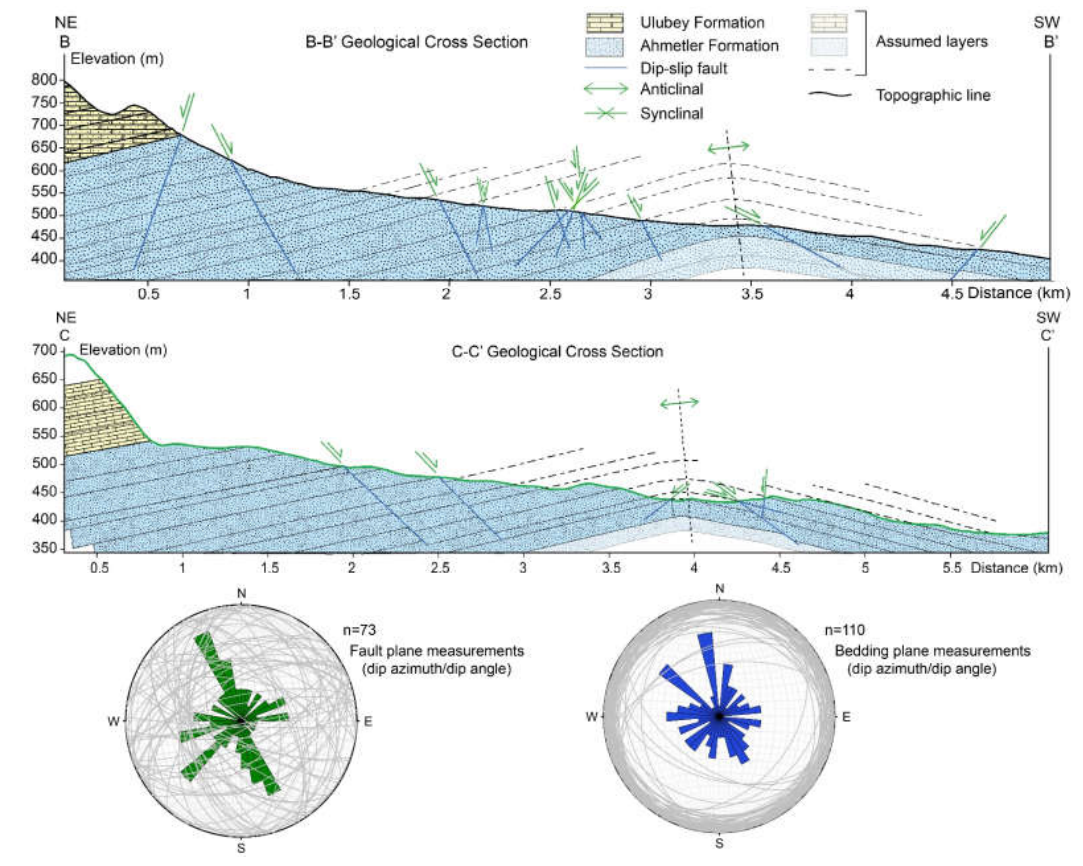
Figure 10. Geological cross sections of bedrock showing the fault geometry and rock structure. There is a vertical exaggeration. Both vertical and horizontal scales are indicated on each profile. Cross section locations are indicated with B-B’ and C-C’ on the geological map in Figure 7. Equal area Stereonets show: Left. Fault plane dip azimuth (green bar), dip angle (grey plots) of all fault measurements in the study basin. Right. Bedding plane dip azimuth (blue bar), dip angle (grey radial plots) of all bedding measurements in the study basin. Displaced fault blocks (typically a down-dip movement) were observed in between both NE-SW facing faults (cross section B-B’—the zone between 0.5–1.5 km) and/or SW-facing faults (cross section C-C’—the zone between 2–3 km). These subsiding block zones produce space for landscape adjustment in the present topography.